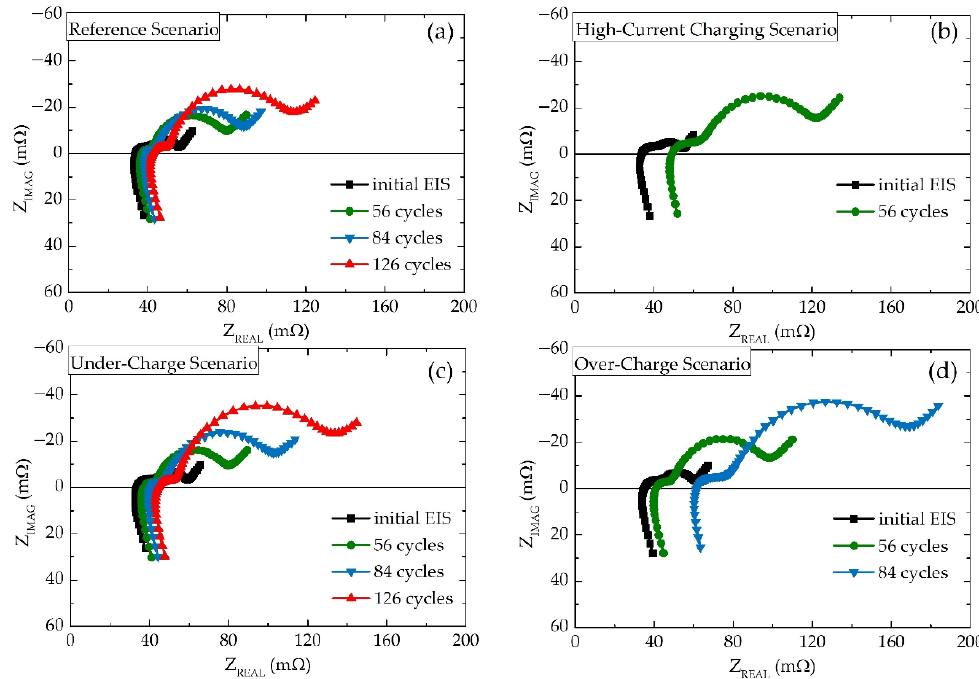
Figure 3. Results of the EIS measurements represented as Nyquist plots for ( a ) Reference Scenario , ( b ) High-Current Charging Scenario , ( c ) Under-Charge Scenario , and ( d ) Over-Charge Scenario .